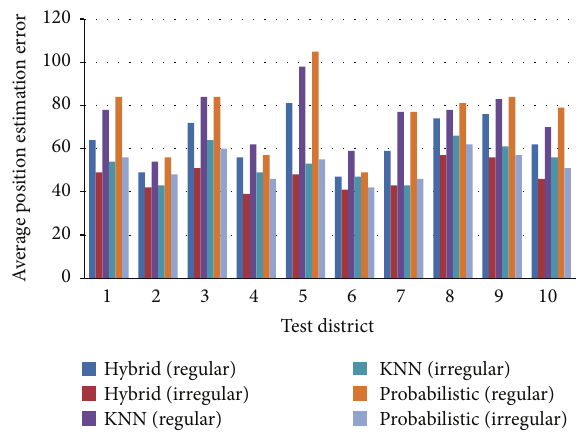
Figure 13: Comparison of regular and irregular grid